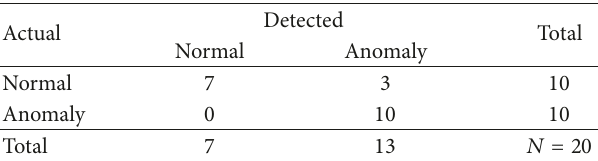
Table 3: Performance evaluation of the anomaly detection opera- tion using confusion matrix.